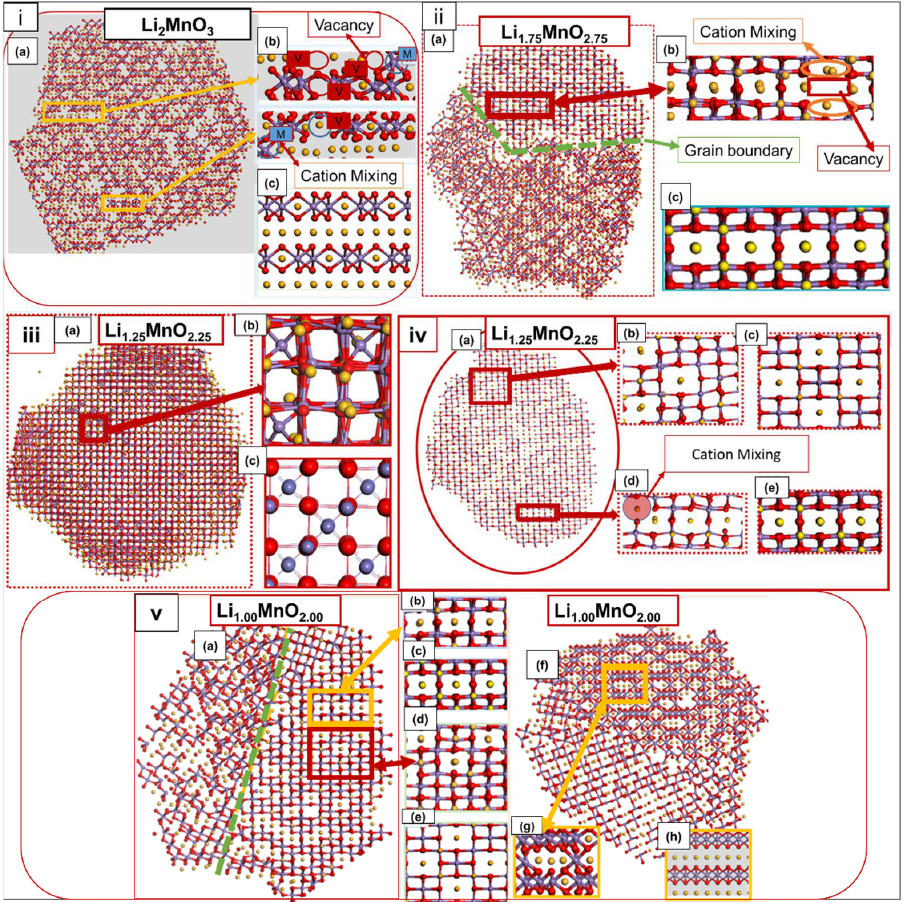
Figure 5. [ i ]. ( a ) A cut-through Li 2 MnO 3 and ( b ) magnified portion of the cut through, illustrating the Li 2 MnO 3 component, comparable with ( c ) the cut-through Li 2 MnO 3 perfect model. [ ii ] ( a ) Cut- through Li 1.75 MnO 2.75 , ( b ) magnified portion of ( a ) revealing the Li 2 MnO 3 component, comparable with ( c ) the perfect Li 2 MnO 3 model. [ iii ] ( a ) Li 1.25 MnO 2.25 atomic structures, revealing ( b ) spinel Mn 3 O 4 component, comparable with ( c ) the Mn 3 O 4 perfect model. [ iv ] ( a ) Cut-through Li 1.25 MnO 2.25 , depicting ( b ) spinel LiMn 2 O 4 component, comparable with ( c ) LiMn 2 O 4 perfect model, ( d ) magnified portion from ( a ) illustrating the Li 2 MnO 3 component, comparable with ( e ) Li 2 MnO 3 perfect model. [ v ] ( a ) Cut-through Li 1.00 MnO 2.00 revealing the ( b ) Li 2 MnO 3 component, comparable with ( c ) Li 2 MnO 3 perfect model, ( d ) magnified segment from ( a ) illustrating the LiMn 2 O 4 component, comparable with ( e ) LiMn 2 O 4 perfect model, ( f ) cut through Li 1.00 MnO 2.00 viewed from different orientation revealing ( g ) magnified portion of ( f ) showing, LiMnO 2, component, comparable with ( h ) LiMnO 2 perfect